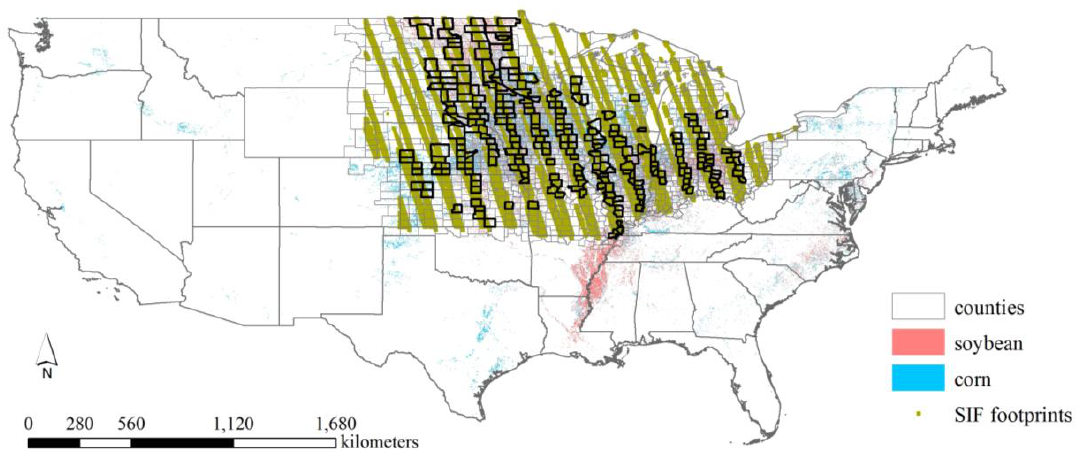
Figure 2. distribution of OCO-2 SIF footprints from 2015 to 2017, and the production area of corn and soybean mapped from the USDA Cropland Data Layer of 2017 (https://nassgeodata.gmu.edu/CropScape/). Regions located within the Midwest 12 states of the U.S. with bold black boundary lines are the counties used in this study.